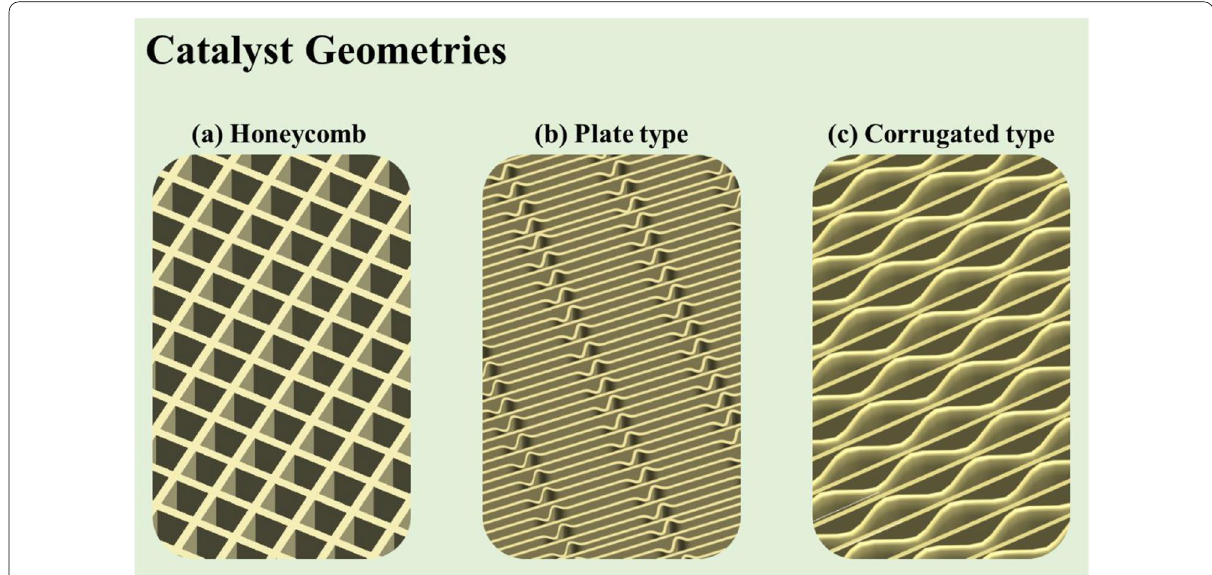
Fig. 10 Type of monolith SCR catalysts: a honeycomb monolith, b plate, and c corrugated type